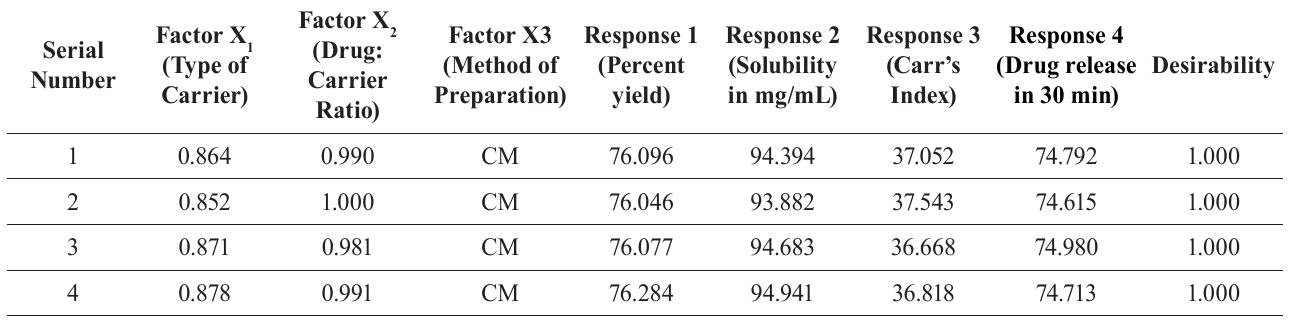
TABLE IV - List of optimum solutions suggested by the I-optimal design by numerical optimization technique